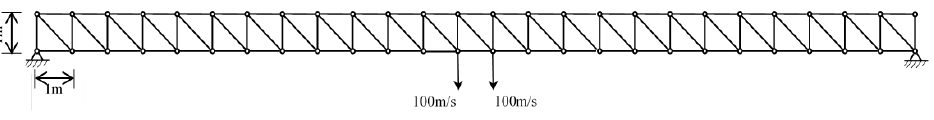
Figure 12. Long span planar skeletal structure.